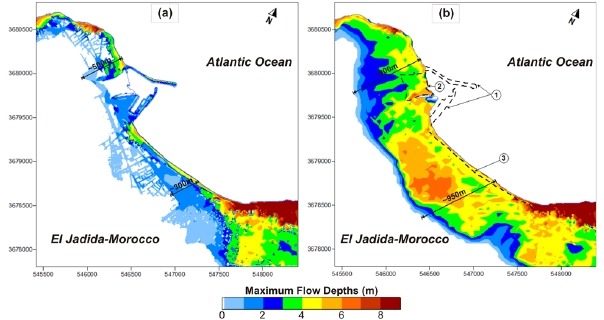
Fig. 12. Overland Impact at El Jadida due to a 1755-like tsunami event: (a) maximum flow depths distribution considering the exist- ing coastal protective structures and buildings; (b) maximum flow depth without coastal defense structures and buildings. The dashed black lines in Fig. 8b represent the protective structures that are con- sidered in the case with coastal structures (Fig. 8a) and that are not taken into account in the case without coastal structures (Fig. 8b): (1) breakwaters, (2) Medina wall, and (3) beach